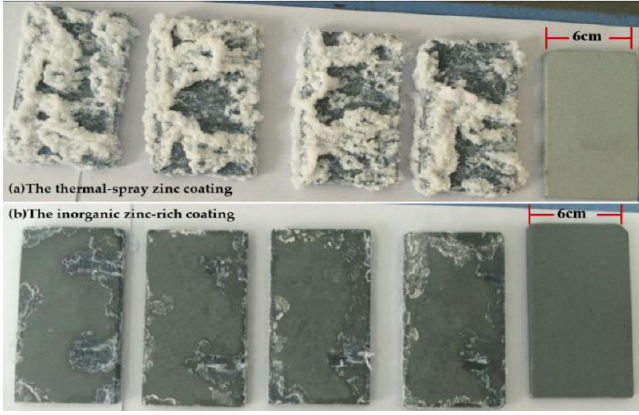
Figure 2. Pictures of coating appearance after 1200 h salt-spray test.